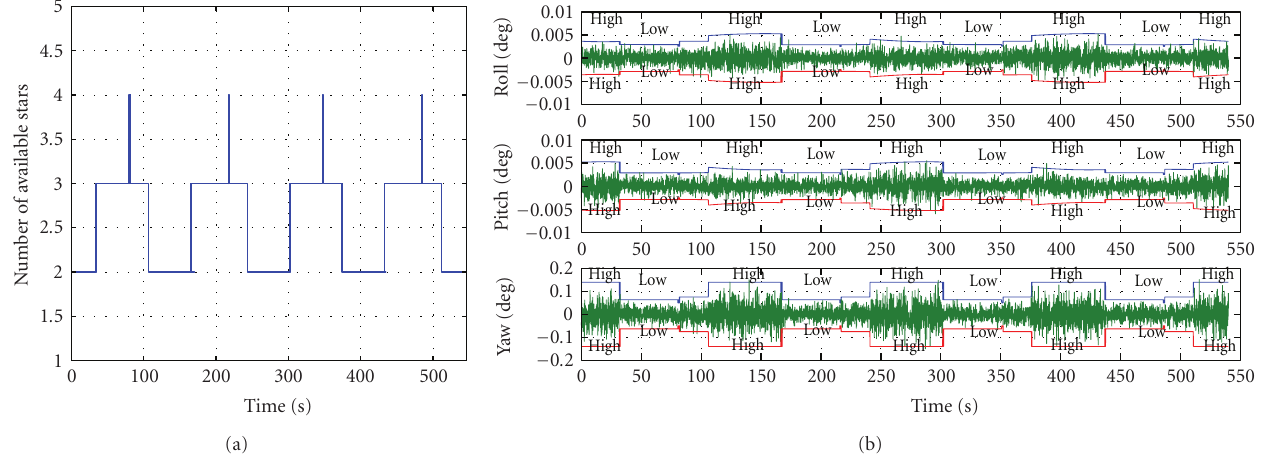
Figure 9: (a) Number of identified stars (b) Star sensor measurement errors and boundaries.